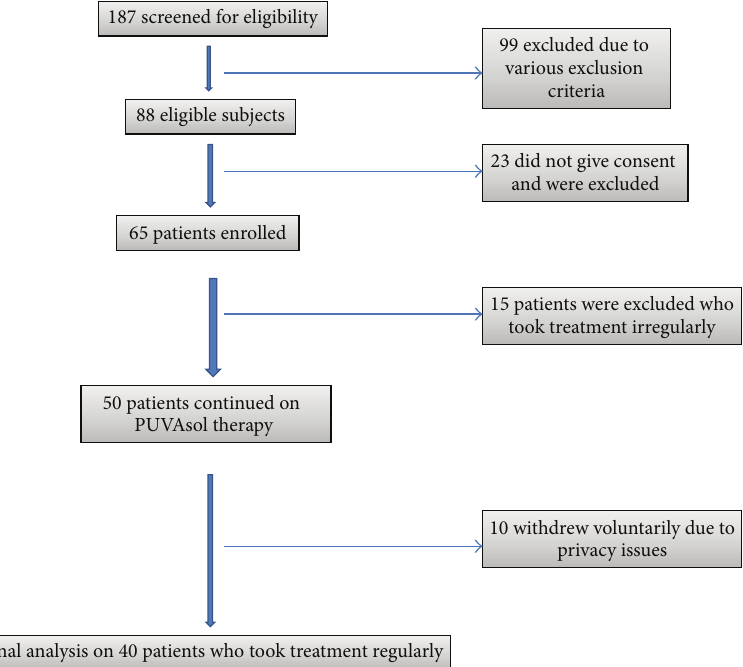
Figure 1: Schematic flowchart of study subjects.